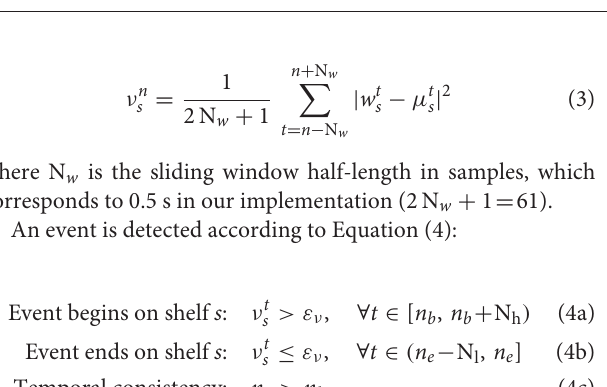
FIGURE 3 | Aggregated weight sensed by a shelf during the first 15 s of one of our experiments (raw in light blue, filtered in dark blue), as well as the events detected by FAIM (orange) and the annotated ground-truth (purple). Two products were picked up in this section of the